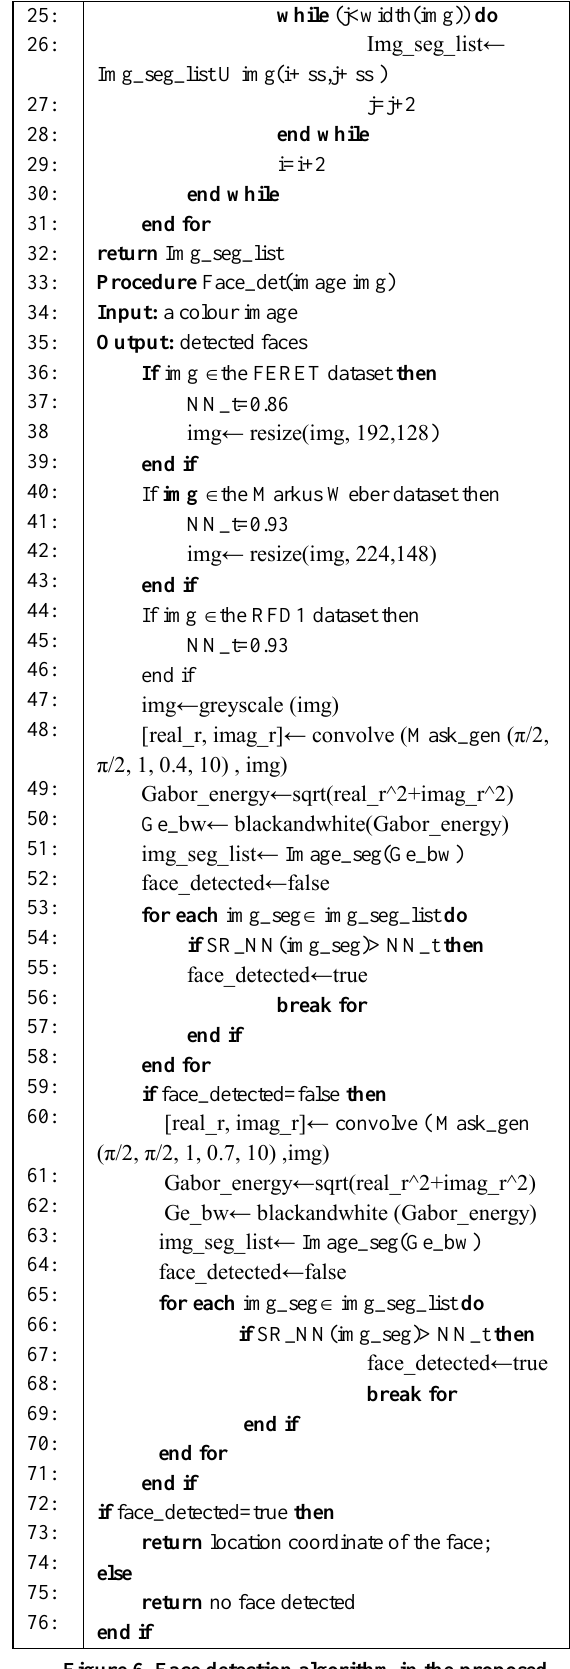
Figure 6. Face detection algorithm in the proposed